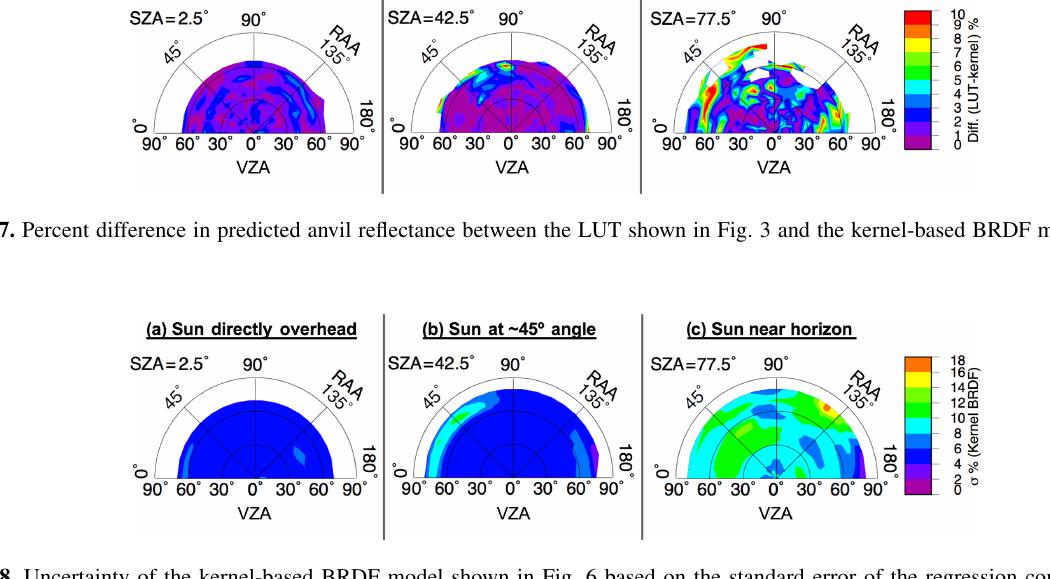
Figure 8. Uncertainty of the kernel-based BRDF model shown in Fig. 6 based on the standard error of the regression computed for the least-squares fit between modeled and observed reflectance